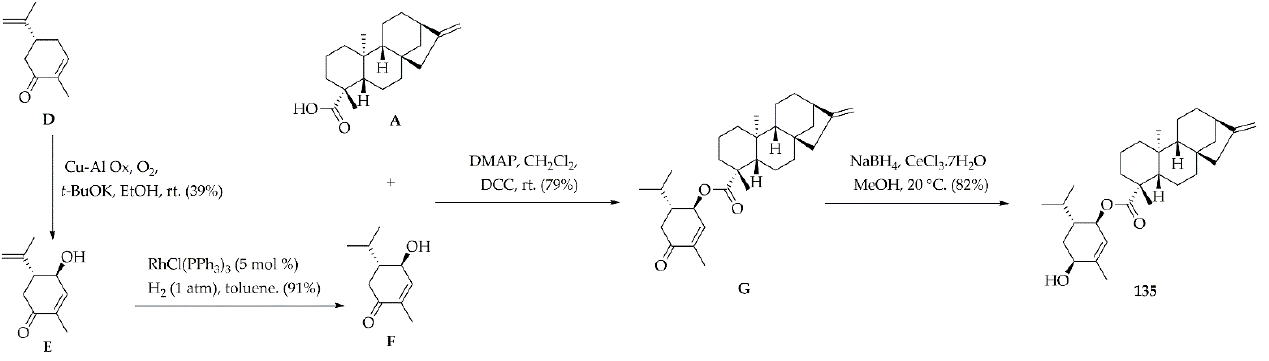
Figure 3. Synthetic route to produce monoterpene/diterpene ester adduct 135 .